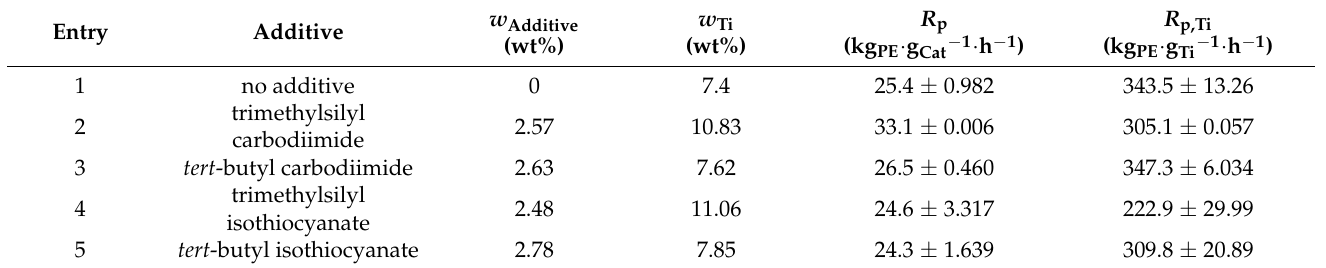
Table 6. Titanium content and polymerization activities related to the catalyst amount and the titanium content for the synthesized catalysts using the modified magnesium